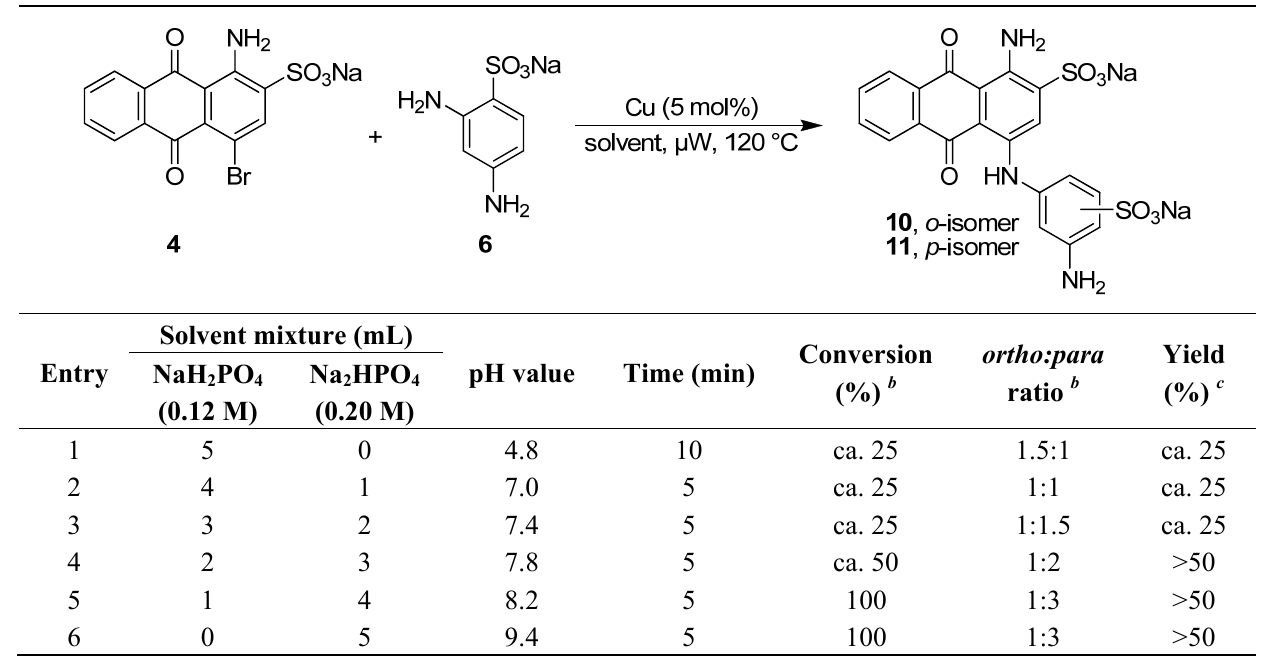
Table 4. Effects of different pH values on the coupling reaction of bromaminic acid ( 4 ) with 2,4-diaminobenzene sulfonic acid ( 6 ).